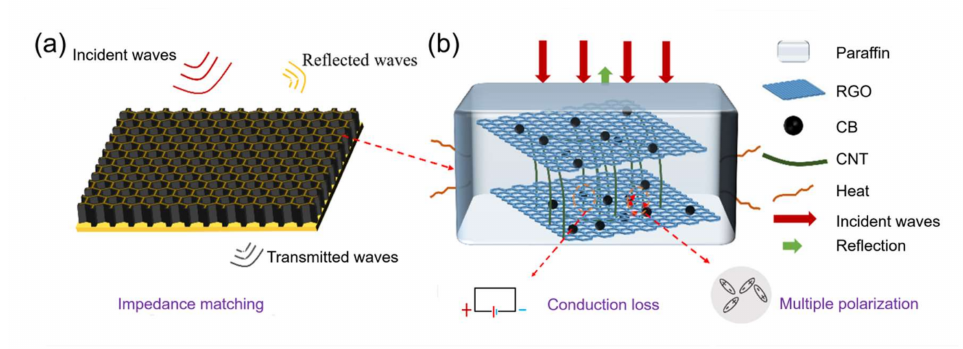
Figure 7. The absorption mechanism of the HC composite: ( a ) macroscopic field; ( b ) microscopic